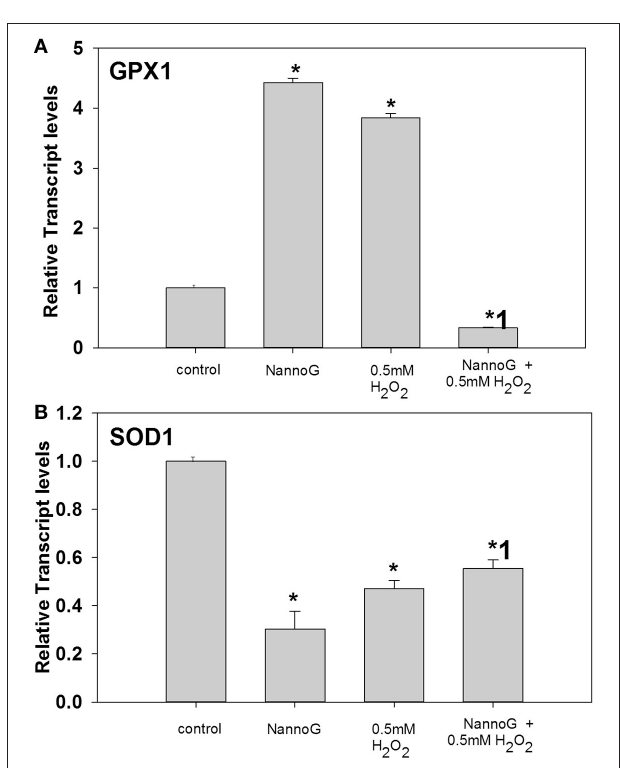
FIGURE 4 | Relative transcript accumulation of glutathione peroxidase-1 (GPX1) (A) and superoxide dismutase-1 (SOD1) (B) genes. The experimental conditions were: control cells, cells treated with H 2 O 2 0.5 mM, cells treated with NannoG (408 µ g/ml) and cells treated with NannoG first and then with H 2 O 2 (0.5 mM). * p < 0.05 significantly different from the control, * 1 p < 0.05 significantly different from the cell treated with H 2 O 2